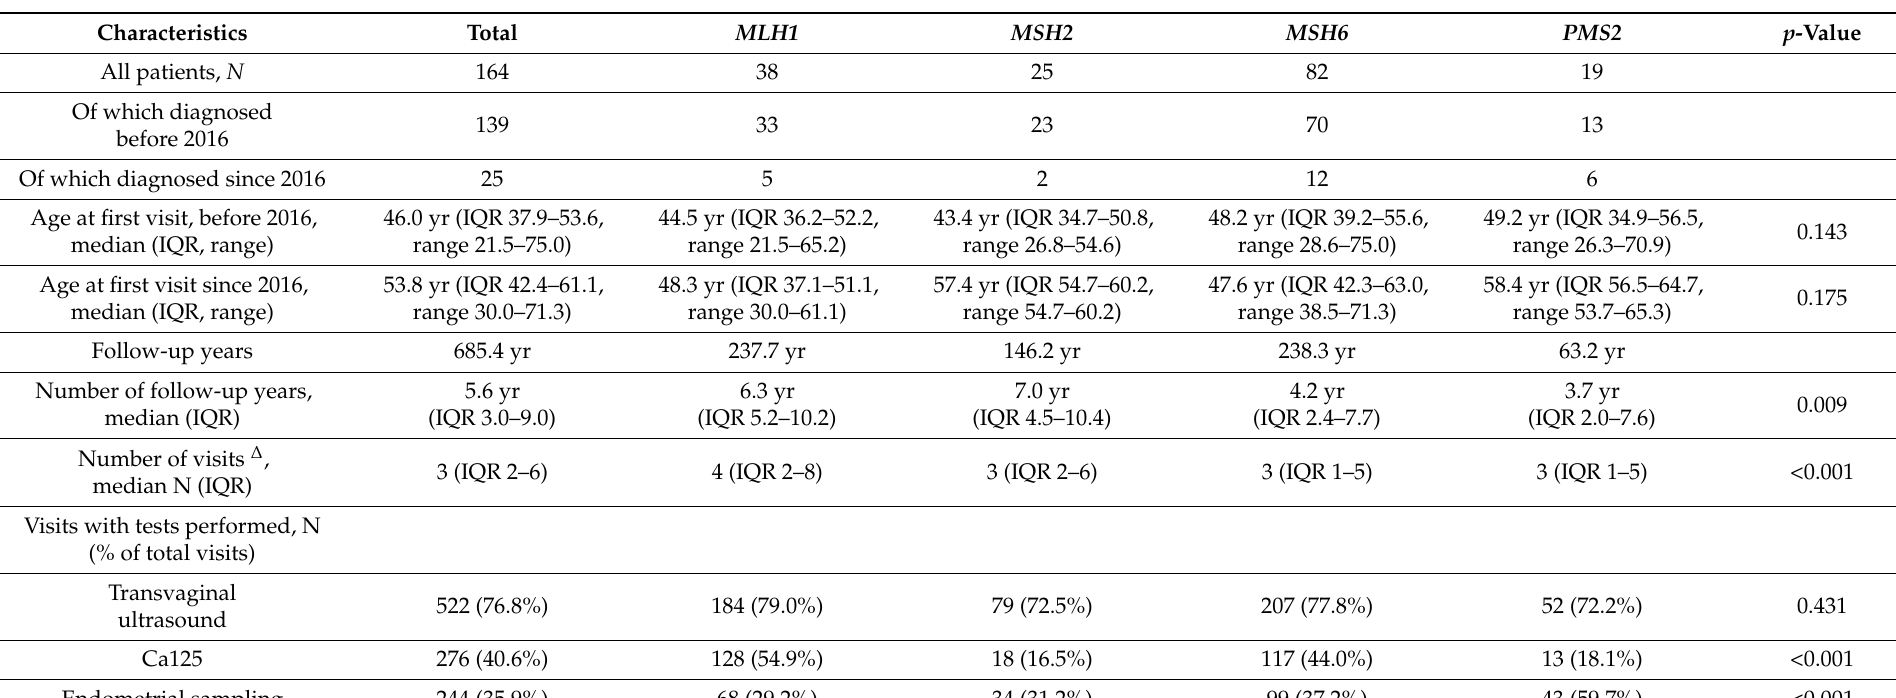
Table 1. Characteristics of carriers with gynecological